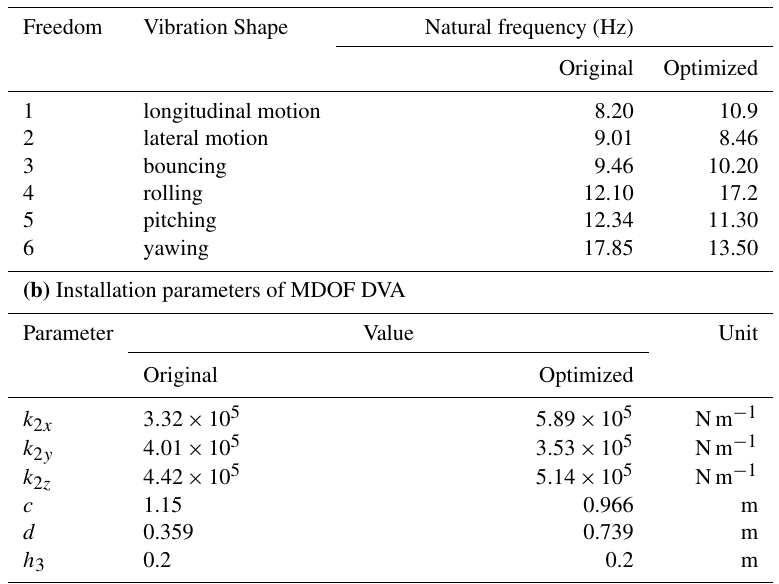
Table 1. Optimized parameters of MDOF DVA. (a) Natural frequency of MDOF DVA before and after optimization.